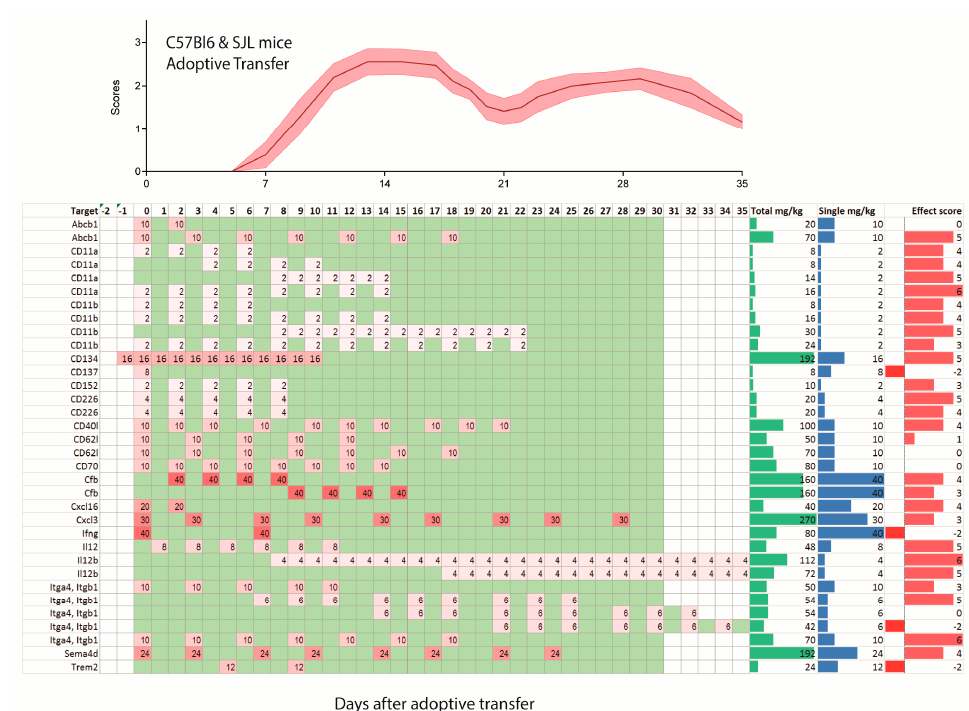
Figure 4. Treatment schedules with monoclonal antibodies in the C57BL6 mice (upper 5 rows) and SJL/J mice after induction of EAE by adoptive transfer of auto-aggressive immune cells obtained from actively immunized mice. The illustration of the time course of the clinical scores after adoptive transfer is based on the literature. The schedule ranges from − 2 days before adoptive transfer up to 35 days and is color-coded as in Figure 2. The darker the red, the higher was the single dose. Days without treatment are green, days without observation white. Two schedules with observation times > 35 days were cut.